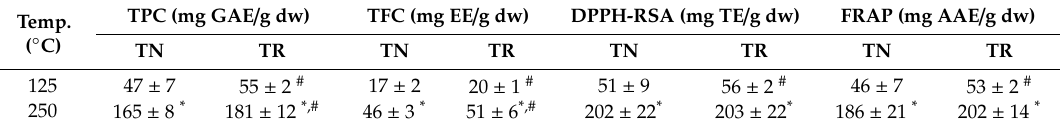
Table 1. Total phenolic content (TPC, results expressed in mg gallic acid equivalents (GAE) / g dw), total flavonoid content (TFC, results expressed in mg epicatechin equivalents (EE) / g